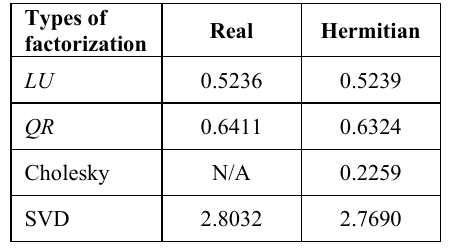
Table 5. Computation time (in second) for 1500 × 1500 matrix.